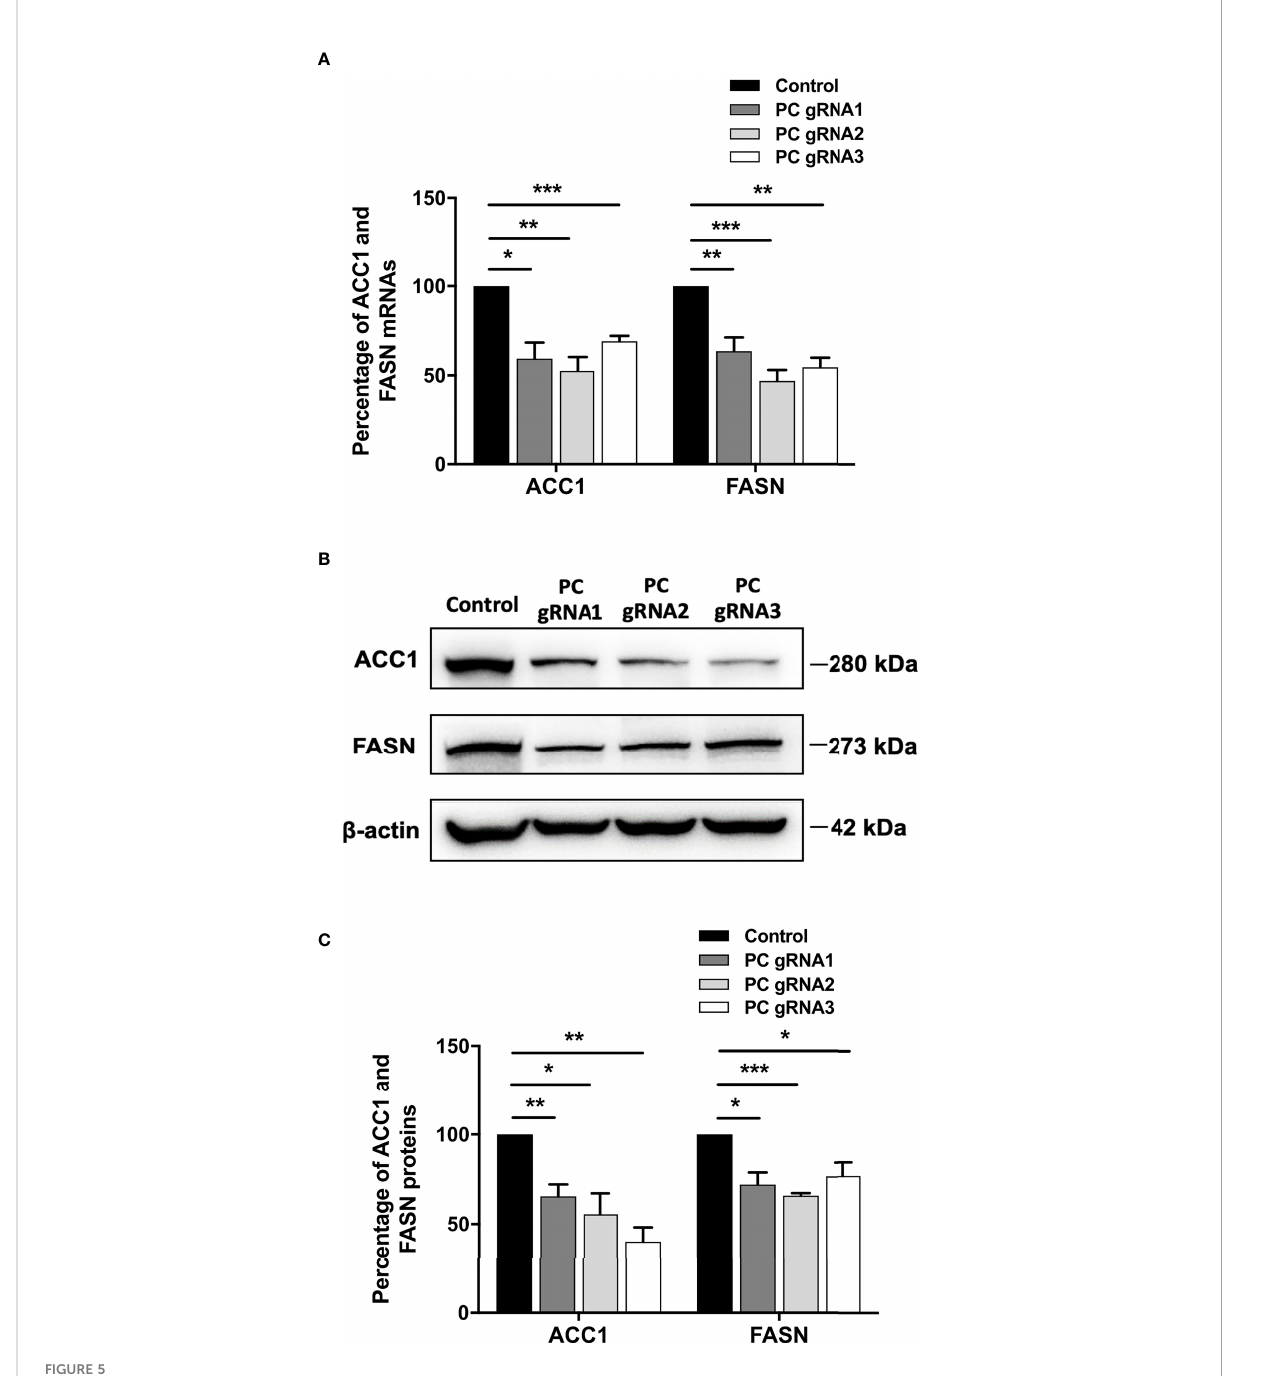
FIGURE 5 Down-regulation of ACC1 and FASN in PC KO HT-29 cells. (A) Percentage of ACC1 and FASN mRNA expression in each PC KO clone compared to that of control HT-29 cell line. (B) Representative Western blots of ACC1 and FASN. (C) Percentage of ACC1 and FASN protein expression quantitated from (B) . The results were obtained from three independent experiments. *p < 0.05, **p < 0.01 and ***p <